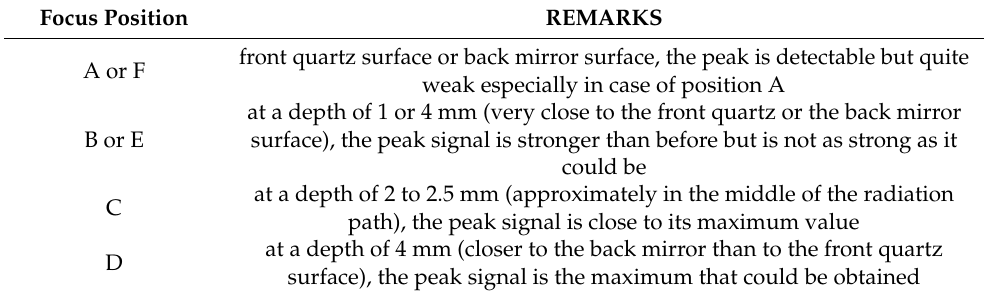
Table 5. Remarks on the position of the focused beam regarding the Raman optic cell, in correlation with the respective spectrum received. The peak mentioned in the remarks is the characteristic PIP peak at 1003 cm − 1 .